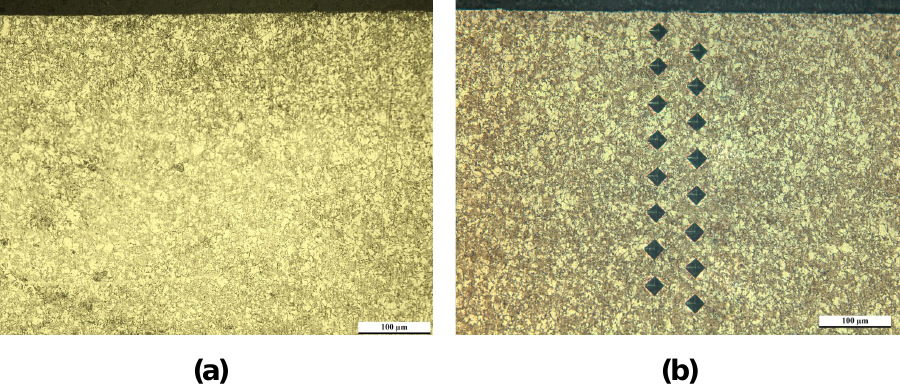
Figure 2. Optical microscopic images of the microstructure in the original state ( a ) and after RCF testing for 7.91 × 10 7 cycles ( b